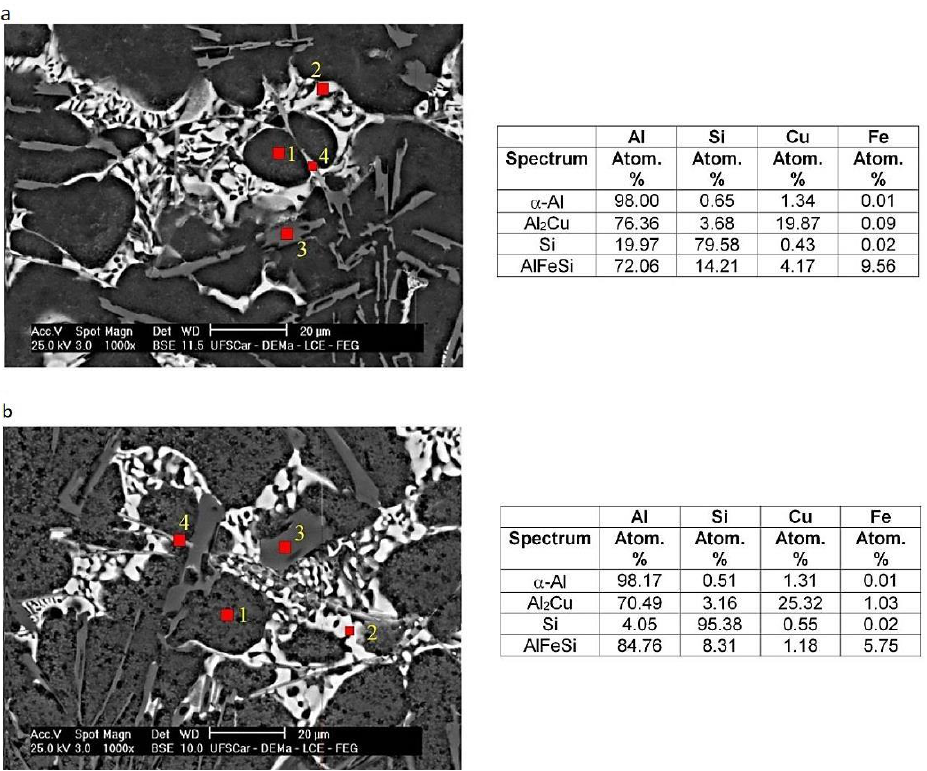
Figure 15. Representative SEM microstructures and EDS microprobe measurements (at. %) related to the positions ( P ) ( a ) 8 mm, and ( b ) 48 mm from the cooled bottom of the Al-11wt. %Si-4.5wt. %Cu alloy.